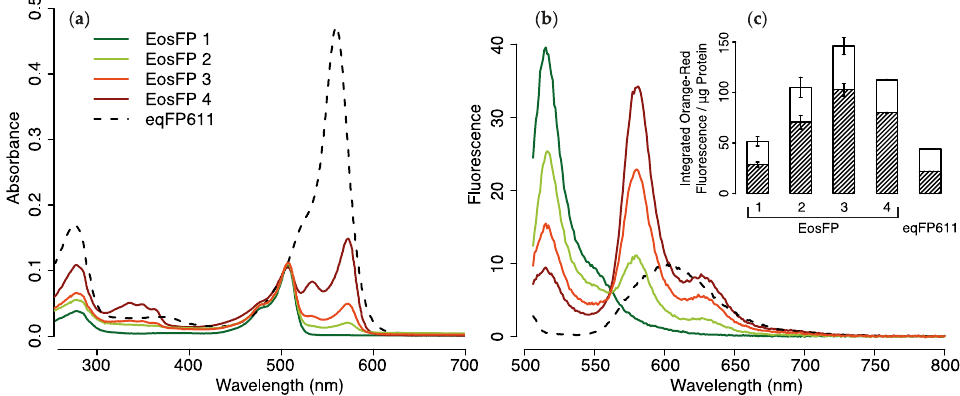
Figure 6. Spectra of purified EosFP at various photoconversion stages (1 = green EosFP; 2,3,4 = partially converted EosFP) vs. eqFP611. Absorbance ( a ); and fluorescence ( b ) spectra; and integrated fluorescence values ( c ) of protein aliquots diluted in PBS pH 7.4 to 0.1 absorbance at 506 nm. Fluorescence spectra obtained with excitation set to 506 nm. Integrated fluorescence normalised to μ g functional protein, concentrations are provided in Table S3. Integrated orange–red fluorescence values measured between 550 and 700 nm, shaded areas represent 560–610 nm portion; ( a , b ) Mean, n